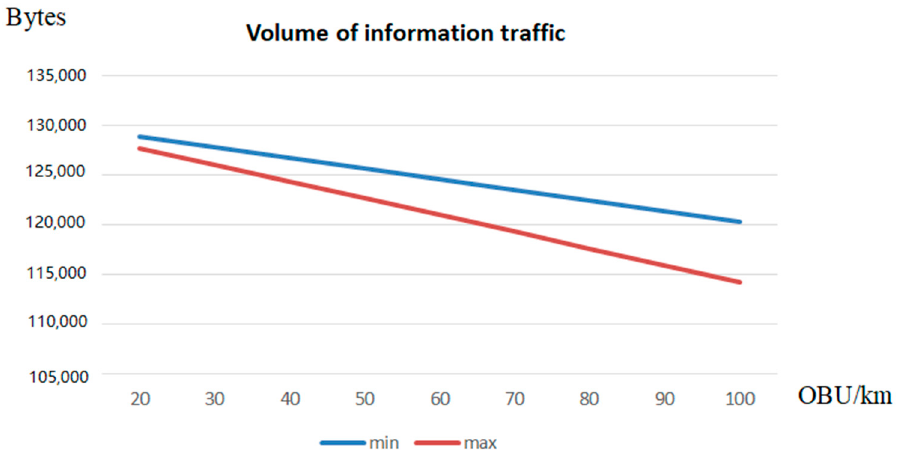
Figure 1. Dependence of the volume of information traffic on road traffic intensity with a 32-bit protocol.